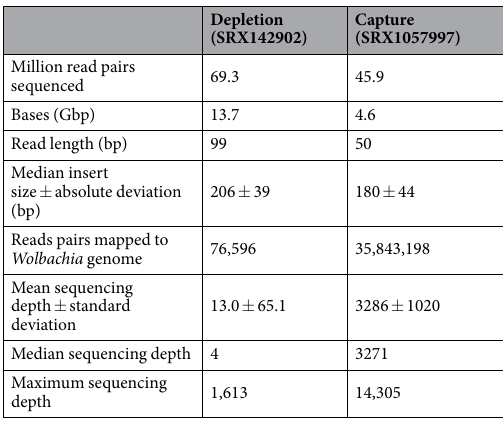
Table 1. Sequencing Statistics for the Capture and Depletion Data